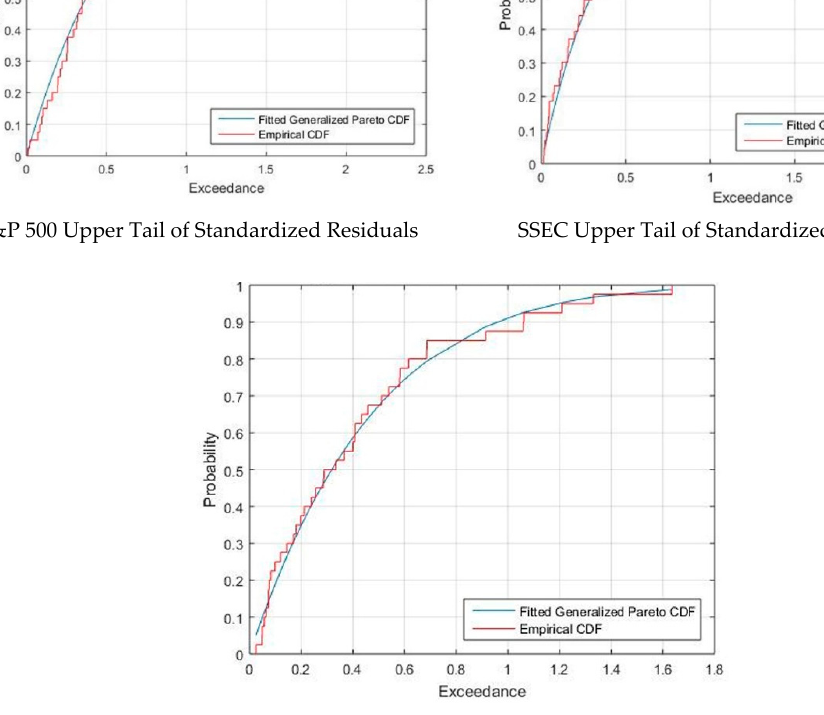
Figure A1. In-Sample VaR Figures.